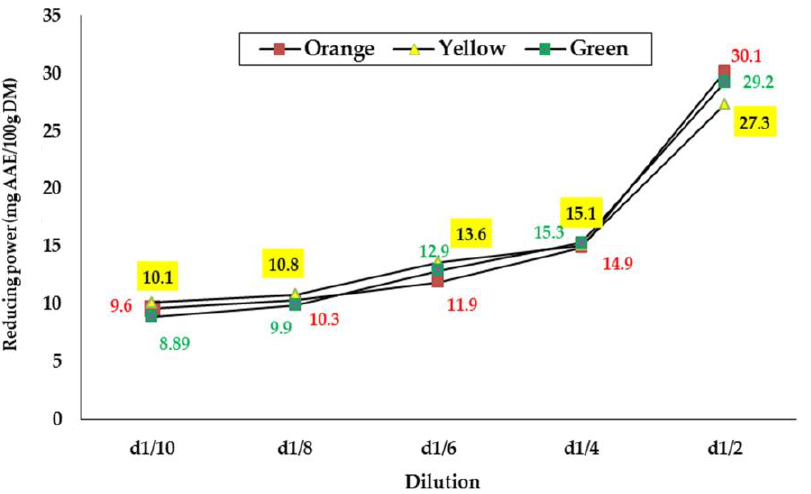
Figure 1. Reducing power of the seed extracts from the three cultivars of prickly pear from the Souk Ahras area, Northeast Algeria.